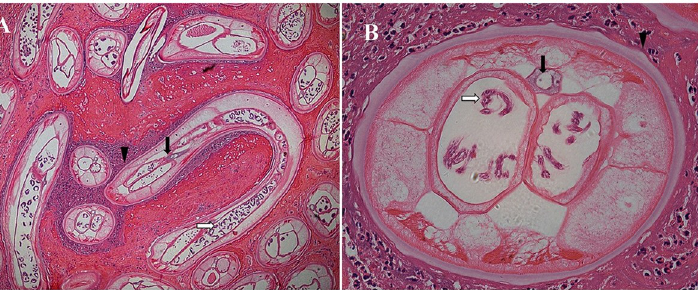
Fig 2. Histopathological examination of the lump after biopsy. Panel A. Hematoxylin and eosin staining shows several adult O . volvulus worms, including an intact longitudinal section of an adult female worm (original magnification × 40). Panel B. Transverse section of a female O . volvulus worm surrounded by inflammatory cells (original magnification × 400). The key diagnostic features include the cuticular rings (darts), paired uterine branches containing coiled microfilaria (white arrows), and the intestine (black